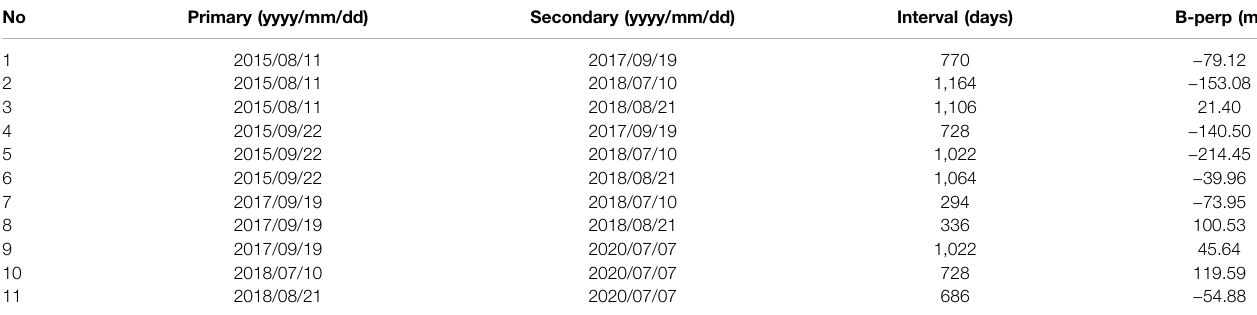
TABLE 1 | Interferometric pairs used in this study. B-perp stands for the distance perpendicular to the line of sight between the positions of the satellite at different